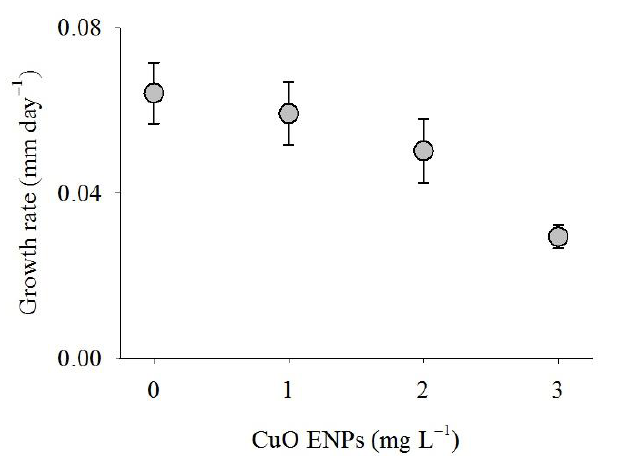
Figure 4. Growth rate of mussels exposed to CuO ENPs. Mean growth rate for mussels in the control group and those exposed to CuO ENPs for four weeks. The impact of CuO ENPs on growth rate depended on exposure time (OLS: Growth = 3.16 × 10 −2 + 1.39 × 10 −2 (Concentration) + 1.03 × 10 −2 (Time) − 6.8 × 10 −3 (Concentration × Time), r 2 = 0.20). Error bars are one standard error of the